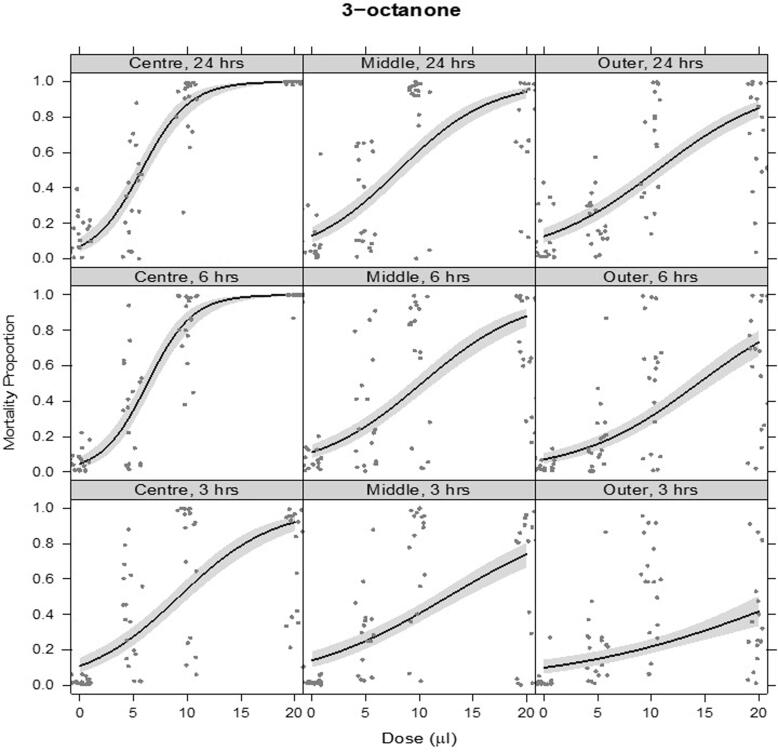
3-octanone. Proportional mortality of PPNs following VOC treatment over a range of dose concentrations (x-axis) and after varying times post treatment (panels by row: 3 hrs, 6 hrs, 24 hrs). This was assessed at varying distances from the centre of a circular arena (panels by column: Centre, Middle, Outer). Fitted lines are from a quasibinomial model of alive and dead nematodes. Shaded ribbons show 95% confidence envelopes. A small amount of horizontal ‘jitter’ was applied to visually separate overlapping data points.